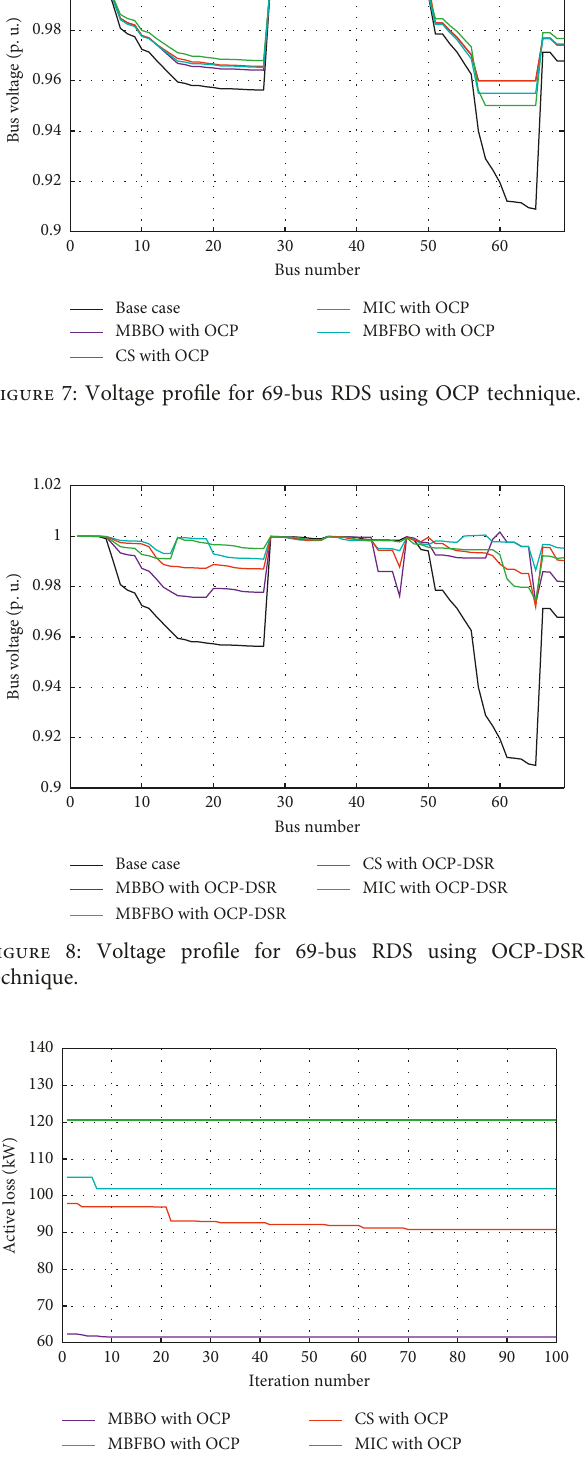
Figure 9: Convergence loss graph for 69-bus RDS using OCP